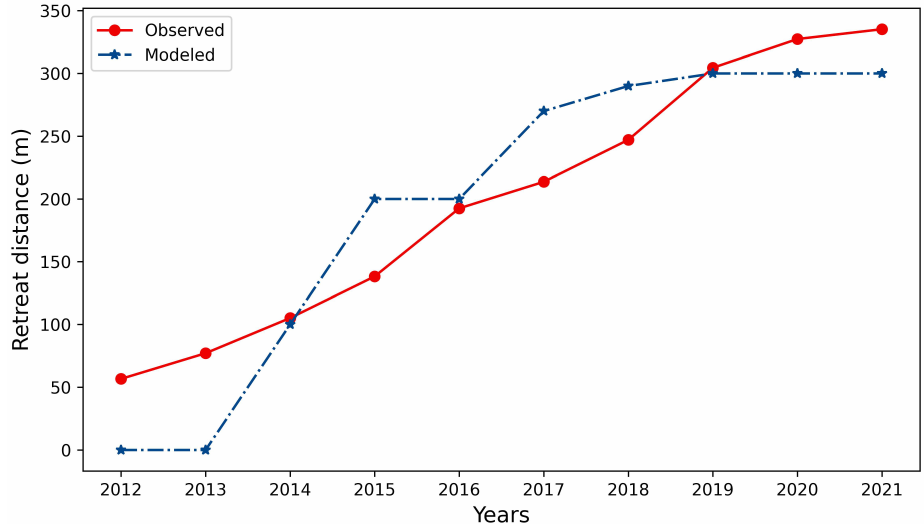
Figure 7. Comparison of the glacier’s termini’s retreat distance between observed and modeled data from 2012 to